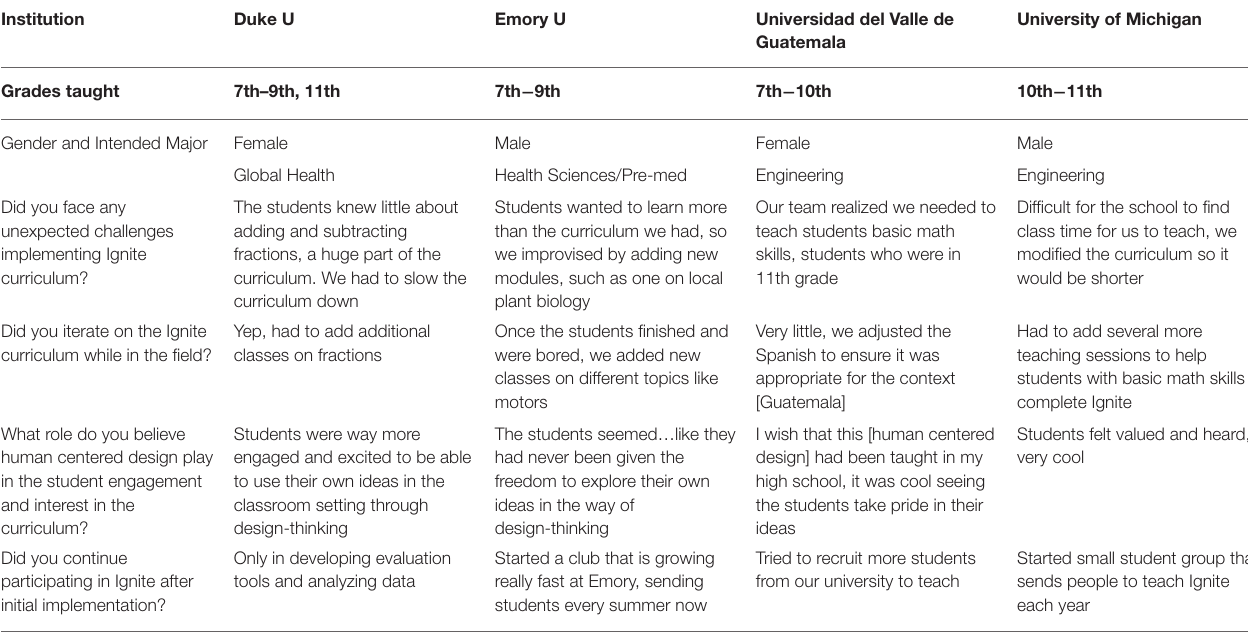
TABLE 1 | Emergent themes from in-depth trainer